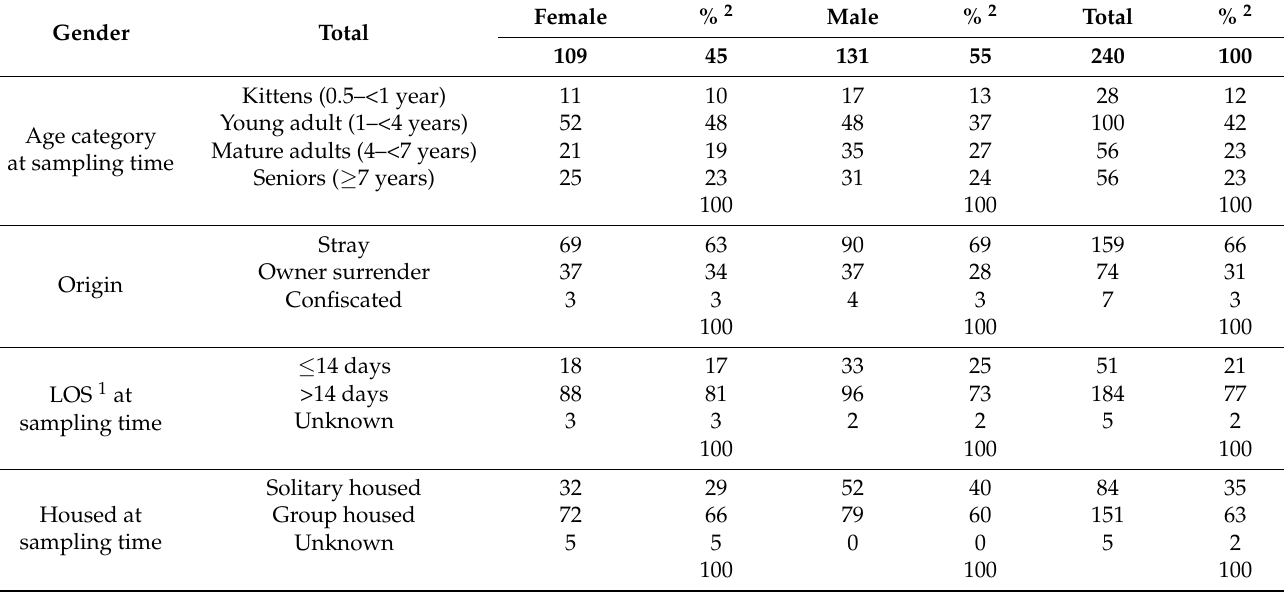
LOS 1 = Length of Stay, time between entry in the shelter and sampling time. % 2 = general distribution per gender, and per gender distribution per